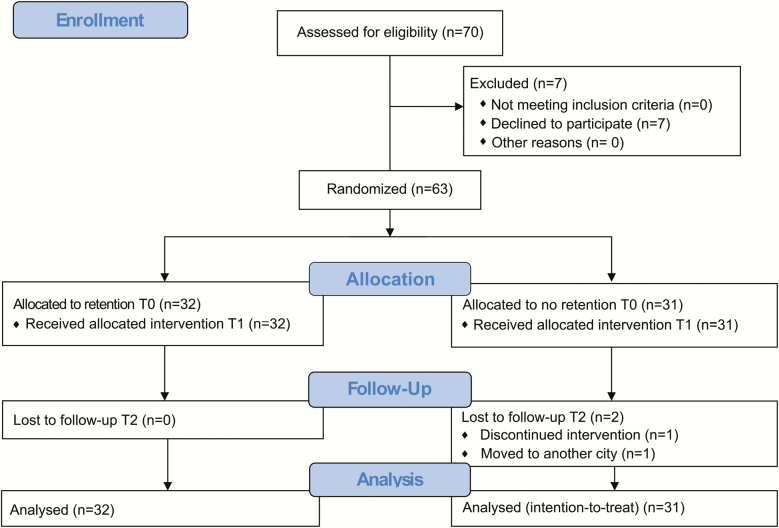
CONSORT flow chart.